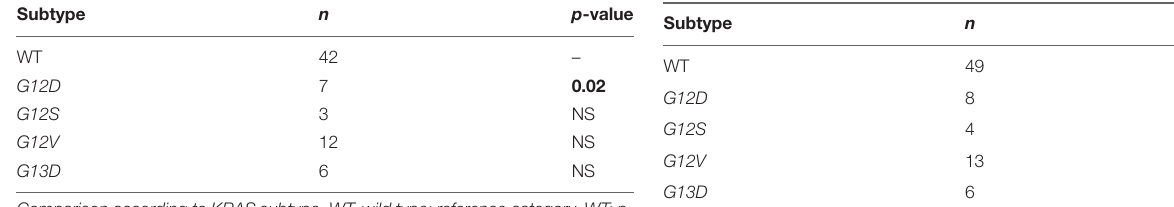
TABLE 6 | Kaplan–Meier analysis of global